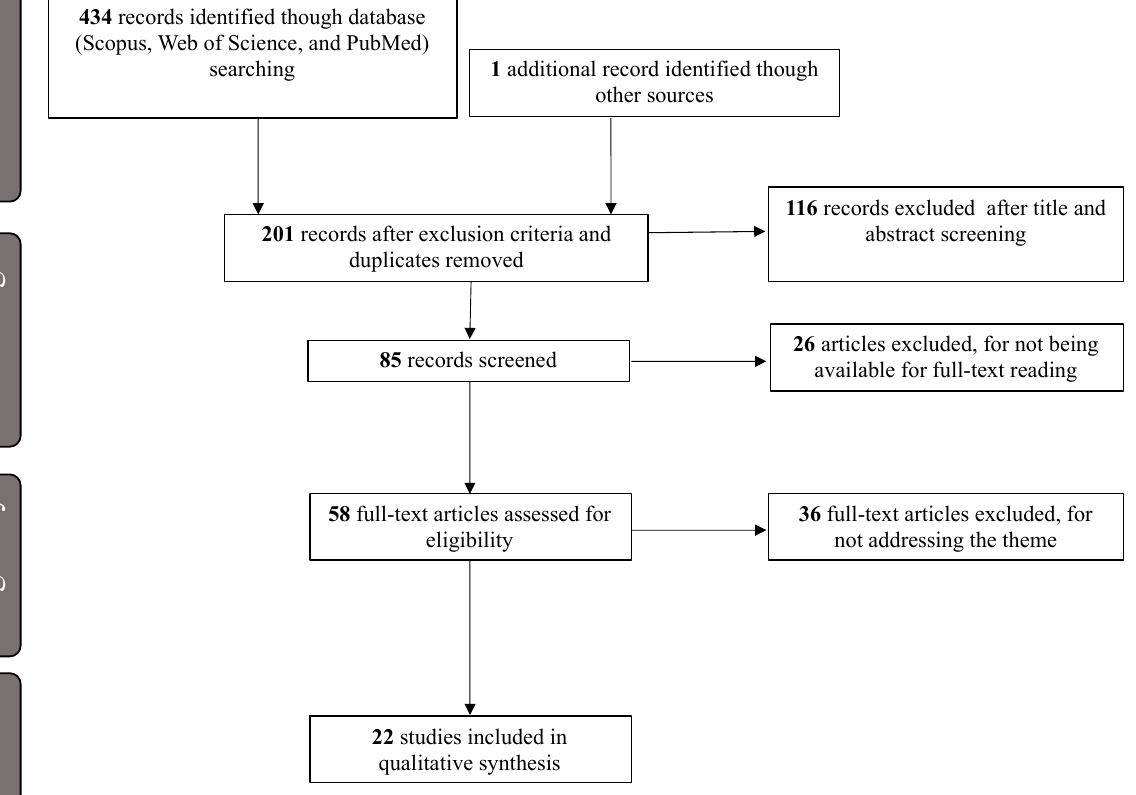
Figure 1. Steps of the PRISMA protocol for the literature review on E&HF in HRC.